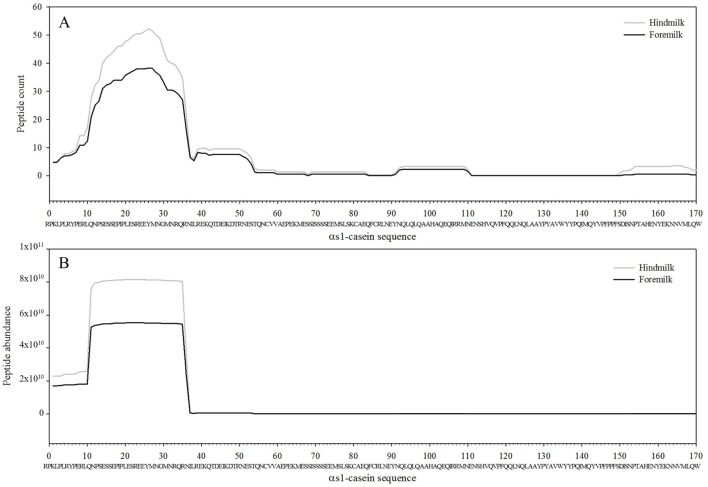
Count (A) and abundance (B) of peptides identified in breast milk mapped on the sequence of αs1-casein.